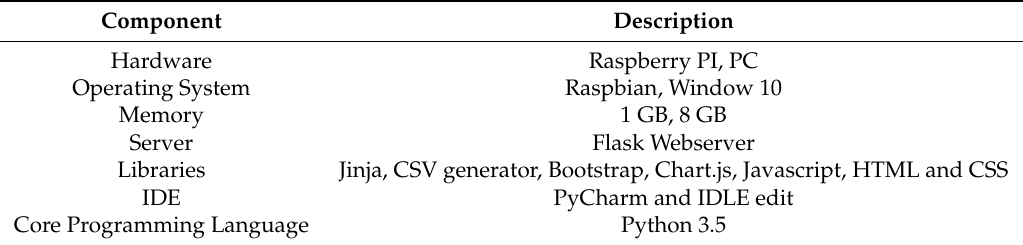
Table 4. Implementation environment for EV